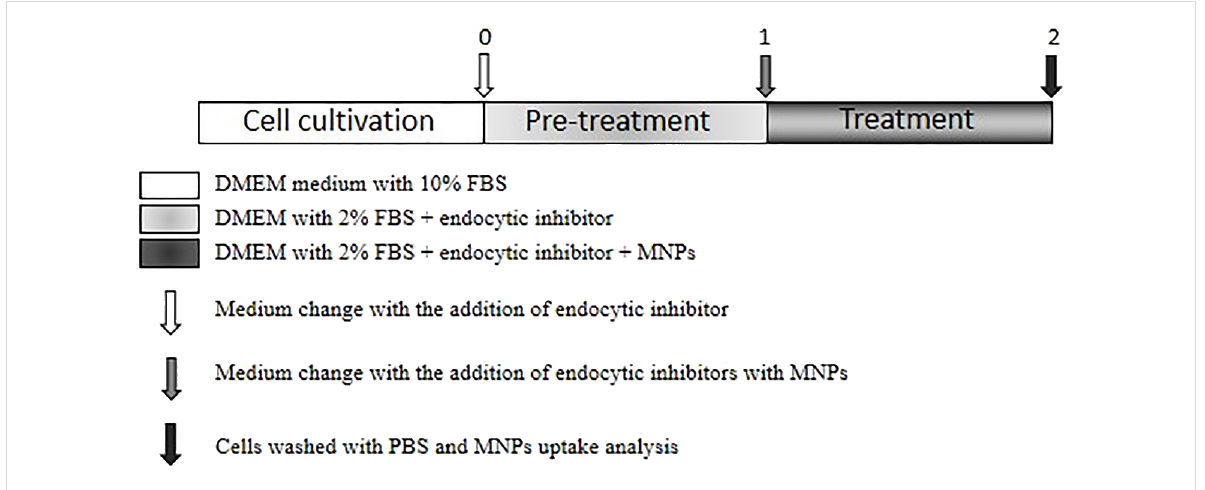
Figure 4: Scheme of cell exposure to endocytic inhibitors and surface-modified MNPs. At 75% to 80% confluence, cells were pre-treated (time 0) with endocytic inhibitor for 1 h in medium with 2% FBS, then (time 1) fresh medium with PEG-SO-MNPs or BSA-SO-MNPs in the presence of the same in- hibitor was added for another period of 1 h. Cell exposure was finished by sucking off the culture medium (time 2) and washing the cells twice with phosphate-buffered saline (PBS).